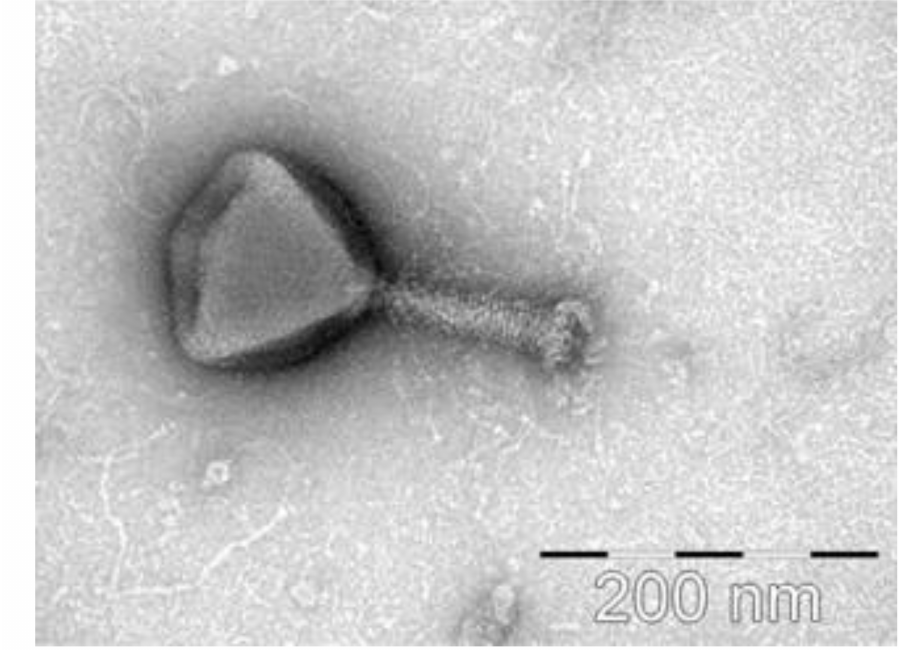
Figure 6. Transmission electron microscopy of Pectobacterium phage vB_PcaM_CBB. The scalebar is 200 nm. The image was kindly provided by Dr. Colin Buttimer and Dr. Aidan